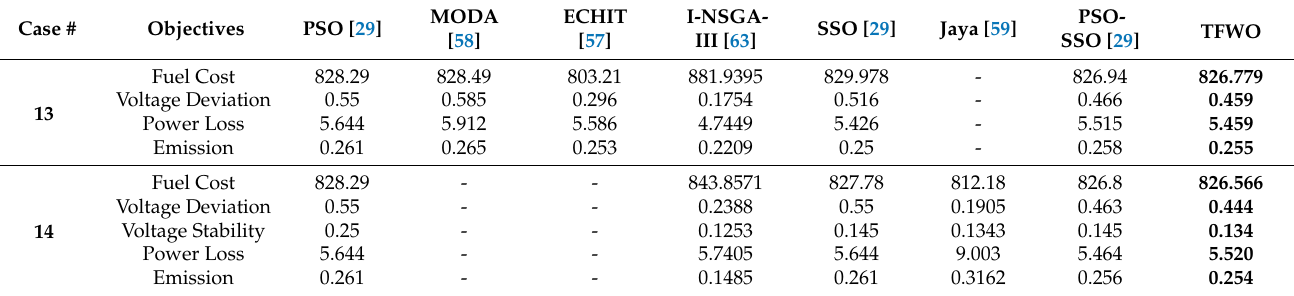
Figure 3. Tri-objective Pareto set of OPF in IEEE 30-bus test system for Cases 10–12. ( a ) Case 10 (Fuel cost, Voltage deviation, and Emissions); ( b ) Case 11 (Fuel cost, Voltage deviation, and Power Loss); ( c ) Case 12 (Fuel cost, Power losses, and